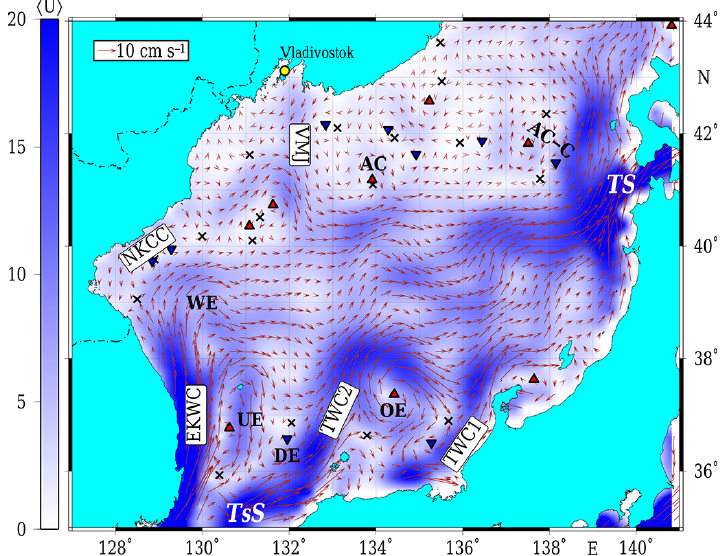
Figure 1. The AVISO velocity field averaged for the period from 2 January 1993 to 15 June 2015. Elliptic and hyperbolic stagnation points with zero mean velocity are indicated by triangles and crosses, respectively. Abbreviations: TsS (Tsushima or Korean Strait), TS (Tsugaru Strait), EKWC (East Korean Warm Current), NKCC (North Korean Cold Current), TWC1 and TWC2 (the first and second branches of the Tsushima Warm Current, UE (Ulleung Eddy), DE (Dok Eddy), OE (Oki Eddy), WE (Wonsan Eddy), AC-C (vortex pair near the eastern gate), AC (anticyclonic eddy over the Japan Basin), VMJ (Vladivostok meridional